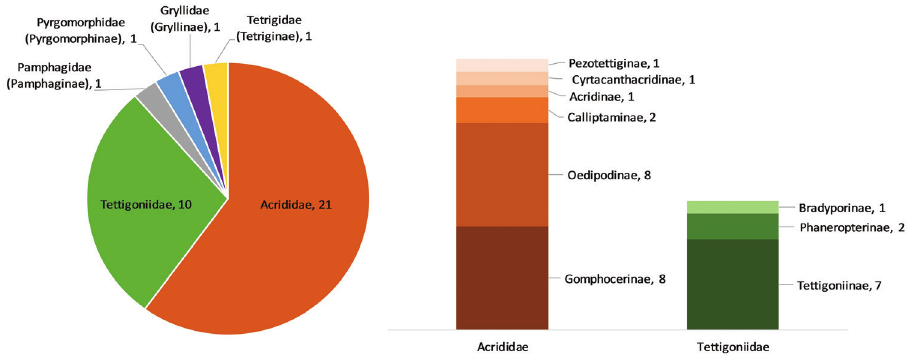
Figure 2. Total number of Orthoptera species per family and per subfamily. The Acrididae and Tettigonidae subfamilies are discriminated in the stacked columns.